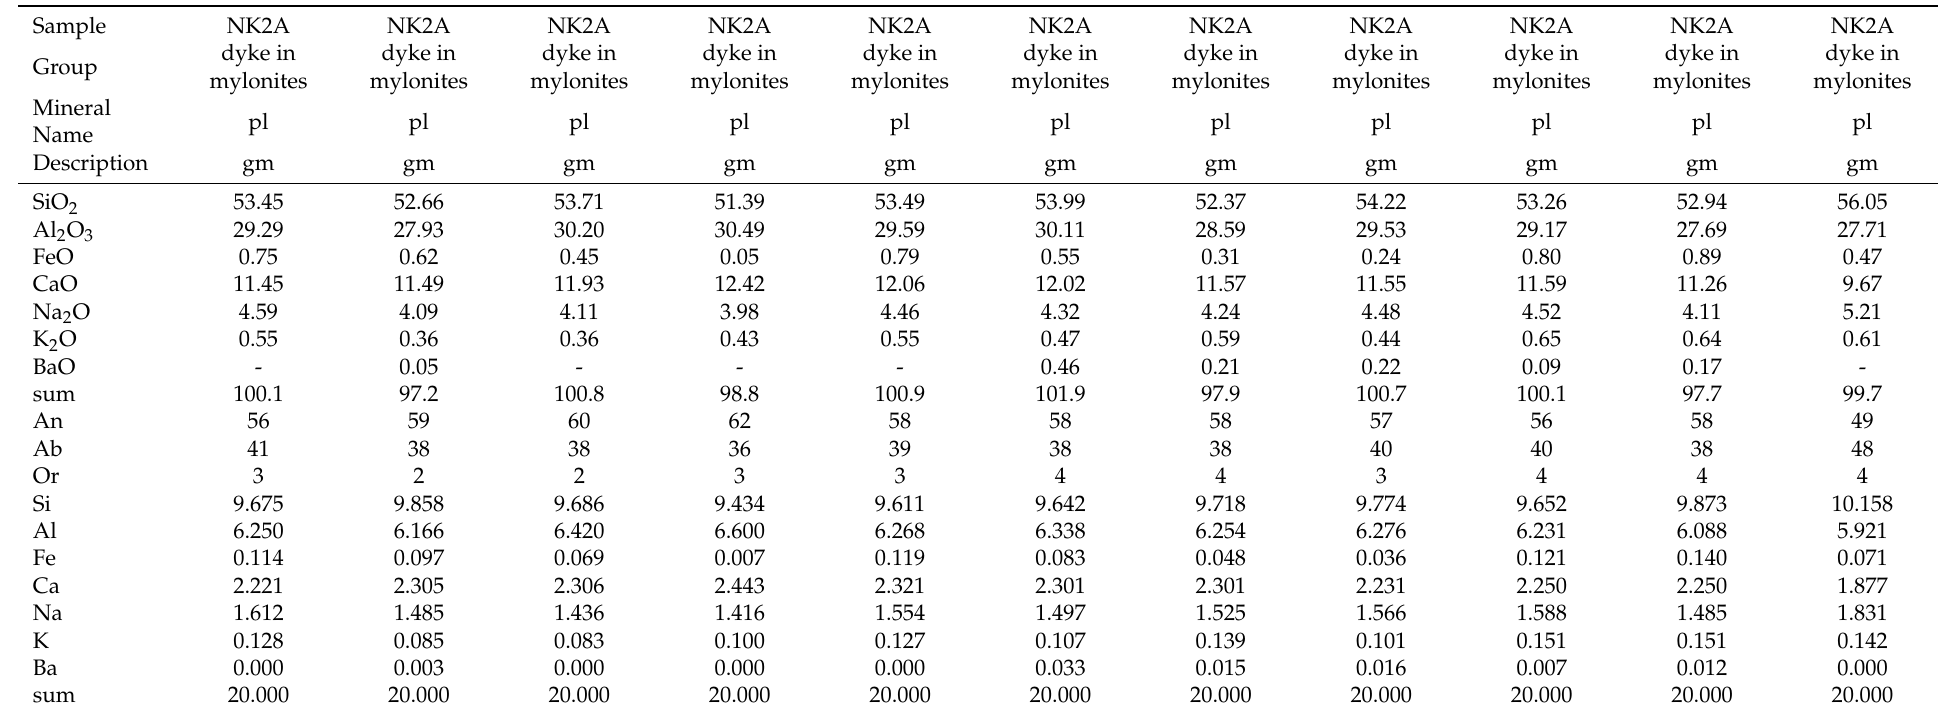
Table 2. Representative chemical analyses (in wt.%) and structural formulas of feldspars of Njimom dykes (western